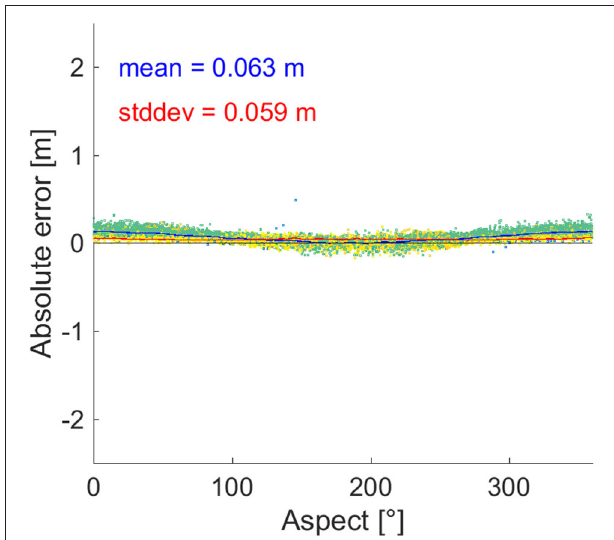
FIGURE 9 | Scatter plot of absolute error of [ALS2] simulation for the winter 2011/12 against aspect. The blue (red) line shows the moving average (standard deviation) for different aspects. The colors indicate land use classification of the grid points (green: rock, yellow: alpine meadow, blue: